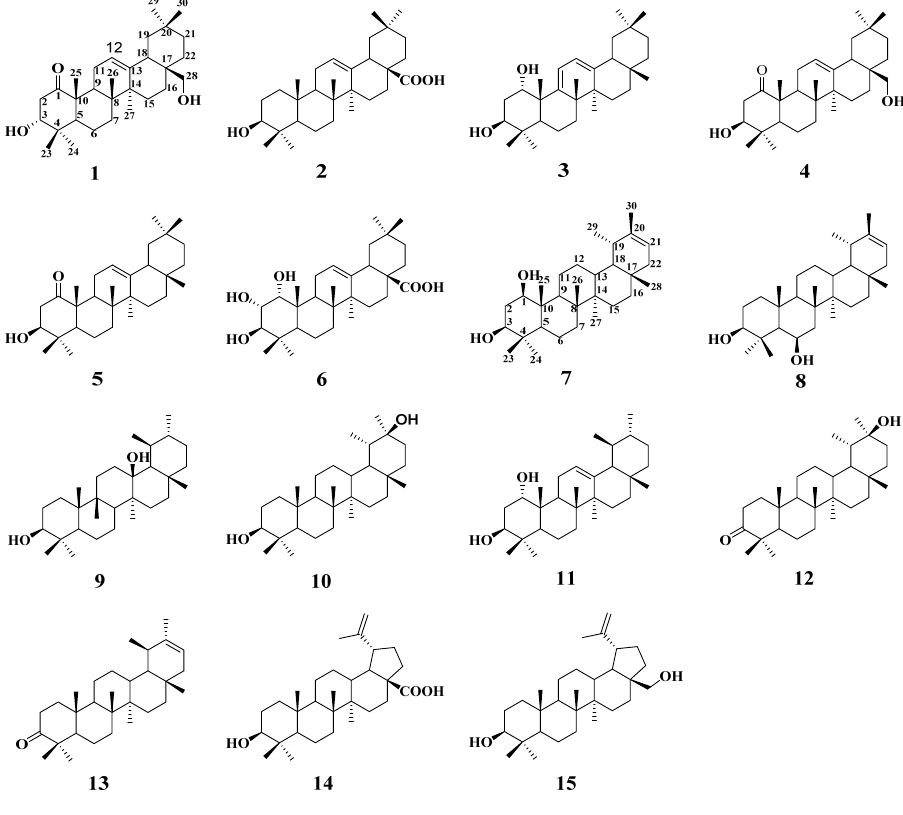
Figure 1. Structures of compounds 1 – 15 .